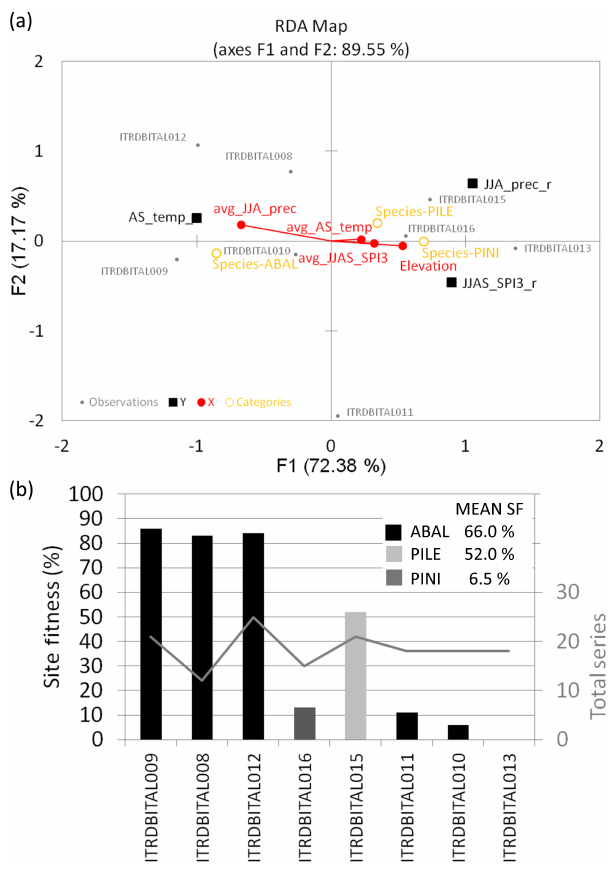
Figure 4. Ordination biplot (RDA analysis) of climate–growth re- lationships (response variables, Y ) and environmental settings (ex- planatory variables X : elevation and climatic averages over the pe- riod 1880–1980) (a) . Site fitness evaluated on single indexed series included in the MXD HSTC chronology (SF; Leonelli et al., 2016) and total series per site (grey line) (b) . Sites are ordered with de- creasing latitude along the x axis. Mean SF values for each species are also reported. ABAL stands for Abies alba ; PILE stands for Pi- nus leucodermis ; PINI stands for Pinus nigra